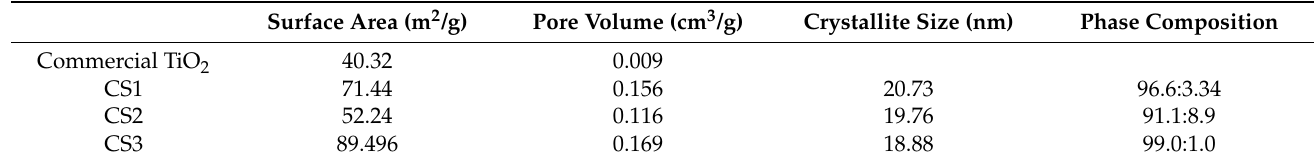
Table 3. The phase composition and crystallite size of hollow titania spheres.